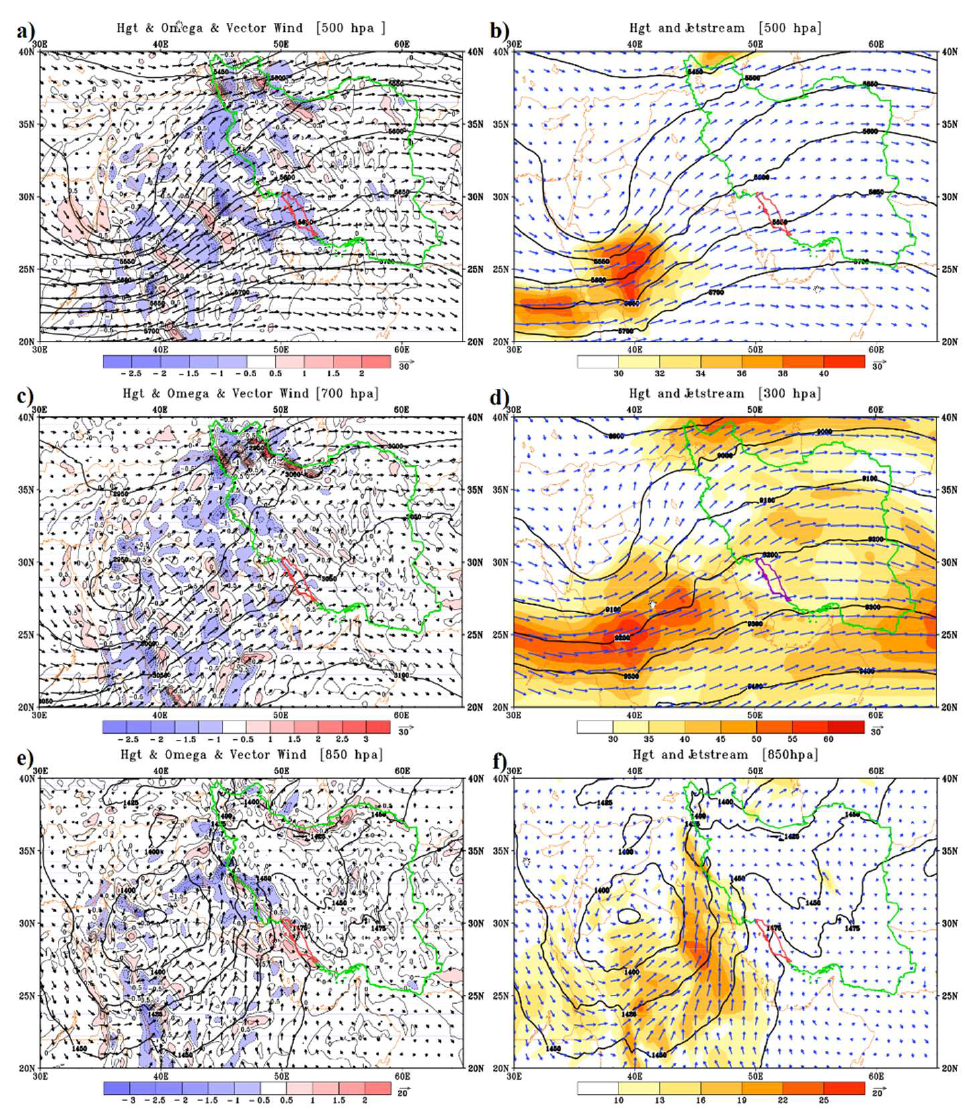
Figure 3. The maps of the geopotential height (HGT) (contours) and the vertical velocity (shaded) of 500 hPa ( a ), a jet stream (shaded) of 500 hPa ( b ) the geopotential height (contours), and the vertical velocity (shaded) of 700 hPa ( c ), a jetstream (shaded) of 300 hPa ( d ), geopotential height (contours) and vertical velocity (shaded) of 850 hPa ( e ) and a jet stream (shaded) of 850 hPa ( f ) on 19 March for 00:00 UTC. The vectors indicate the direction of the wind.